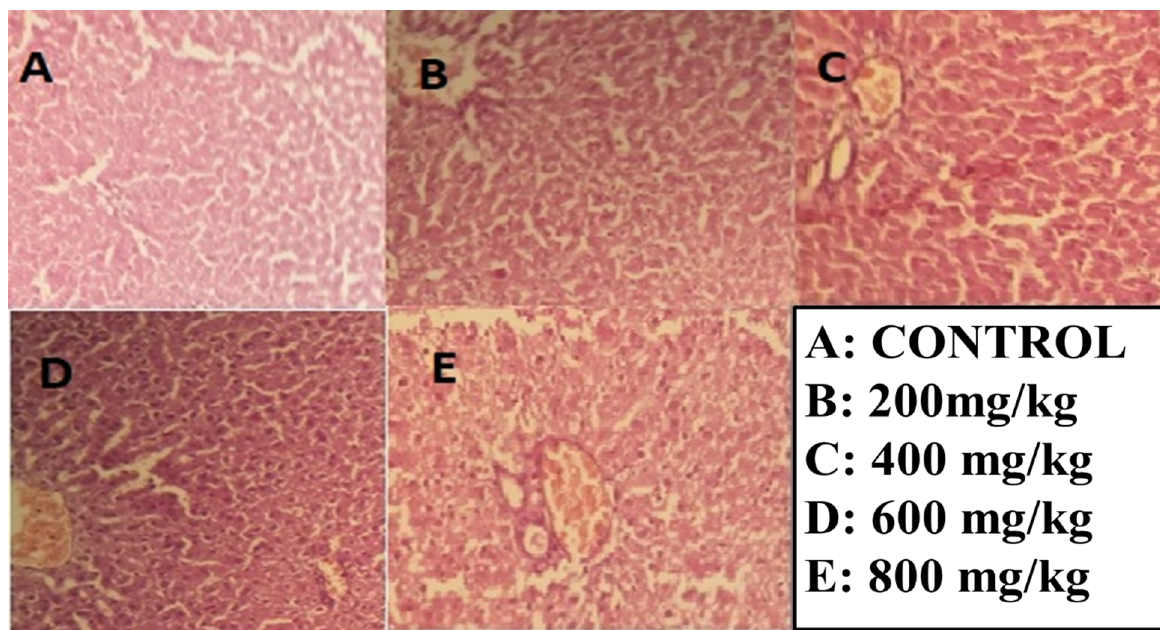
Figure 9. Hepatotoxicity histopathology investigations of the liver section given the ethyl acetate fraction ( A ) No fibrosis with no accumulation of immune cells ( B ) Slight fibrosis with no ballooning ( C ) nuclear degeneration, and no accumulation of immune cells ( D ) Slight portal activity, slight infiltration of macrophages nuclear variation ( E ) no vacuolar degeneration, and hydropic degeneration present.